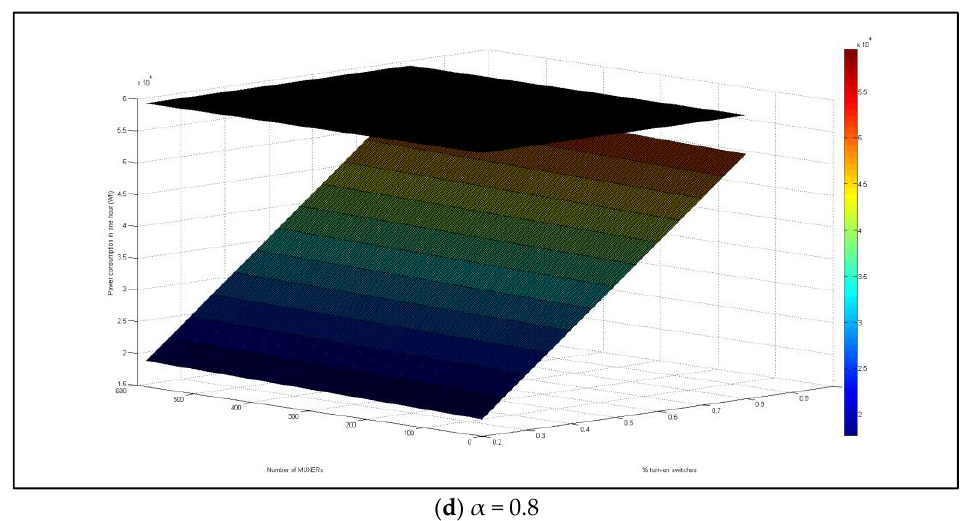
Figure 12. Power consumption results of model 1 and model 2 with n = 584 switches, and α = (0.1, 0.4, 0.6, 0.8). ( a ) α = 0.1; ( b ) α = 0.4; ( c ) α = 0.6; ( d ) α = 0.8.